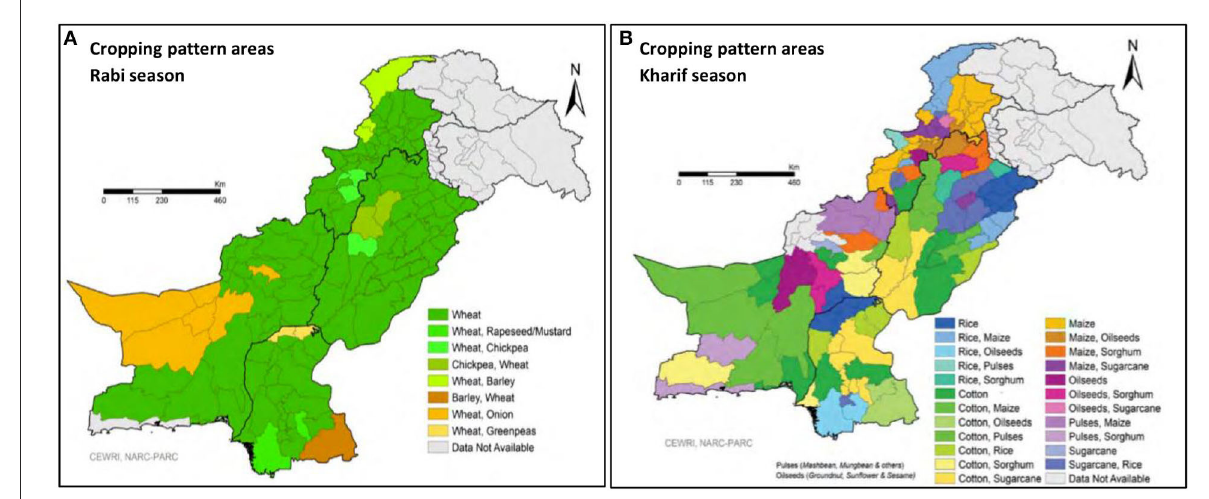
FIGURE1 (A) The cropping pattern areas in the Rabi season (April till November), and (B) The cropping pattern areas of Pakistan in the Kharif season (November till April) [Source: Climate, Energy and Water Research Institute, National Agricultural Research Centre, Pakistan Agricultural Research Council, and the International Maize and Wheat Improvement Center, 2020